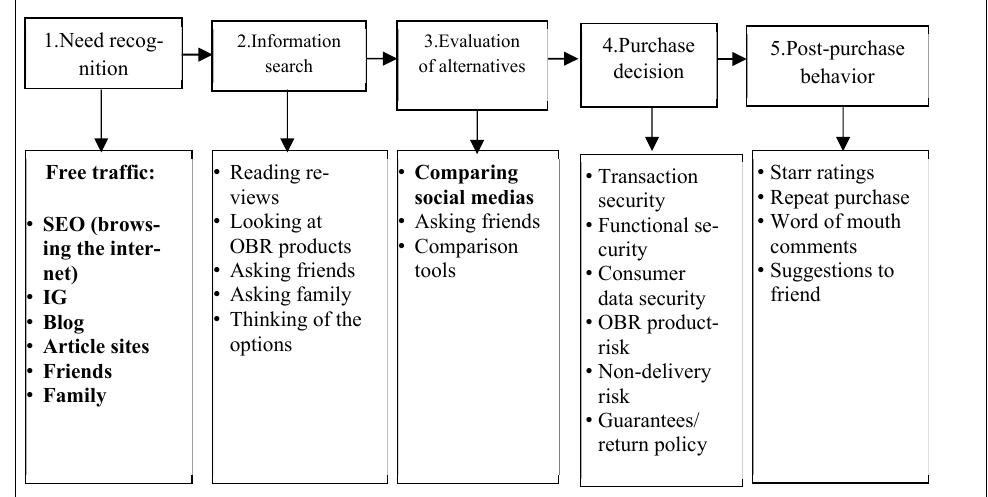
Fig. 4. Conceptual Model of Online OBR Purchase Decision Process via s-commerce